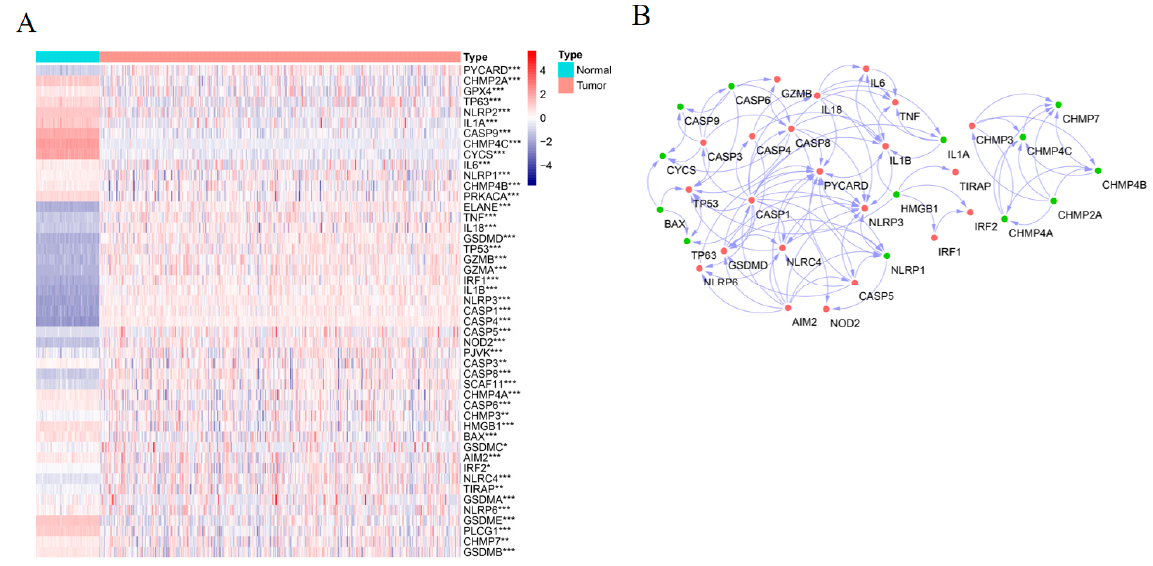
Figure 1. Expressions of the 52 pyroptosis-related genes in AML. ( A ) DEGs Heatmap of the pyroptosis-related genes in the normal (Normal, cyan) and the tumor tissues (Tumor, pink) (purple: low expression level; red: high expression level). p values were shown as: * p < 0.05; ** p < 0.01; *** p < 0.001. ( B ) PPI network indicated the interactions of the DEGs (interaction score = 0.9) (red: upregulated; green: downregulated; arrow: interaction).